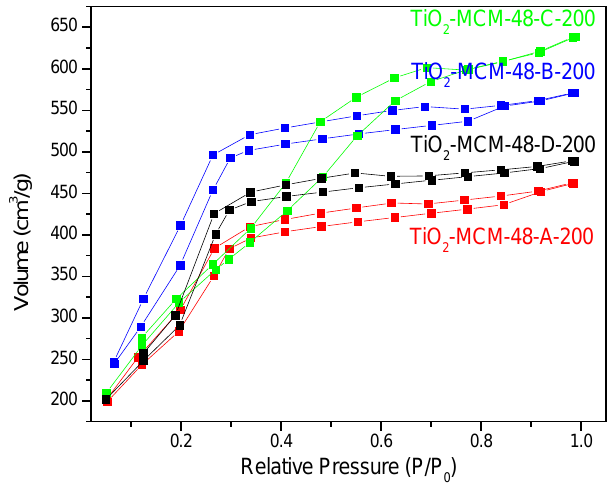
Figure 3. Nitrogen isotherms of TiO 2 -MCM-48-200